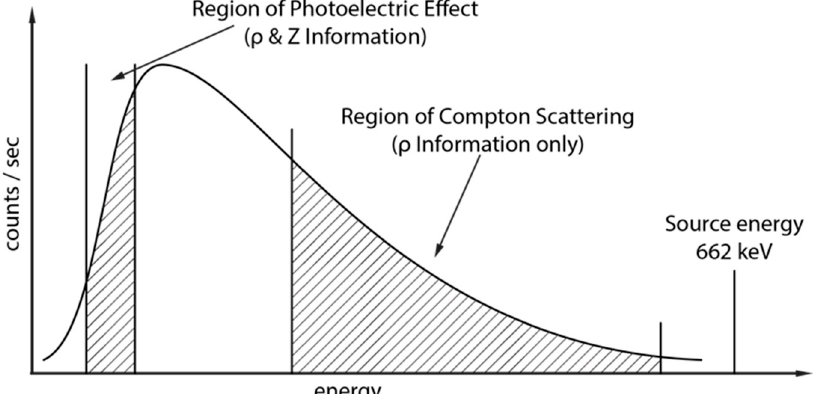
Figure 3. Sketch of the characteristics of a gamma ray spectrum recorded using a lithodensity tool with a 137 Cs source. The high energy region of Compton scattering is indicative of the formation density, the gamma counts recorded in the low energy region are influenced by photoelectric absorption and indicative of density and average atomic number (Z) of a formation.